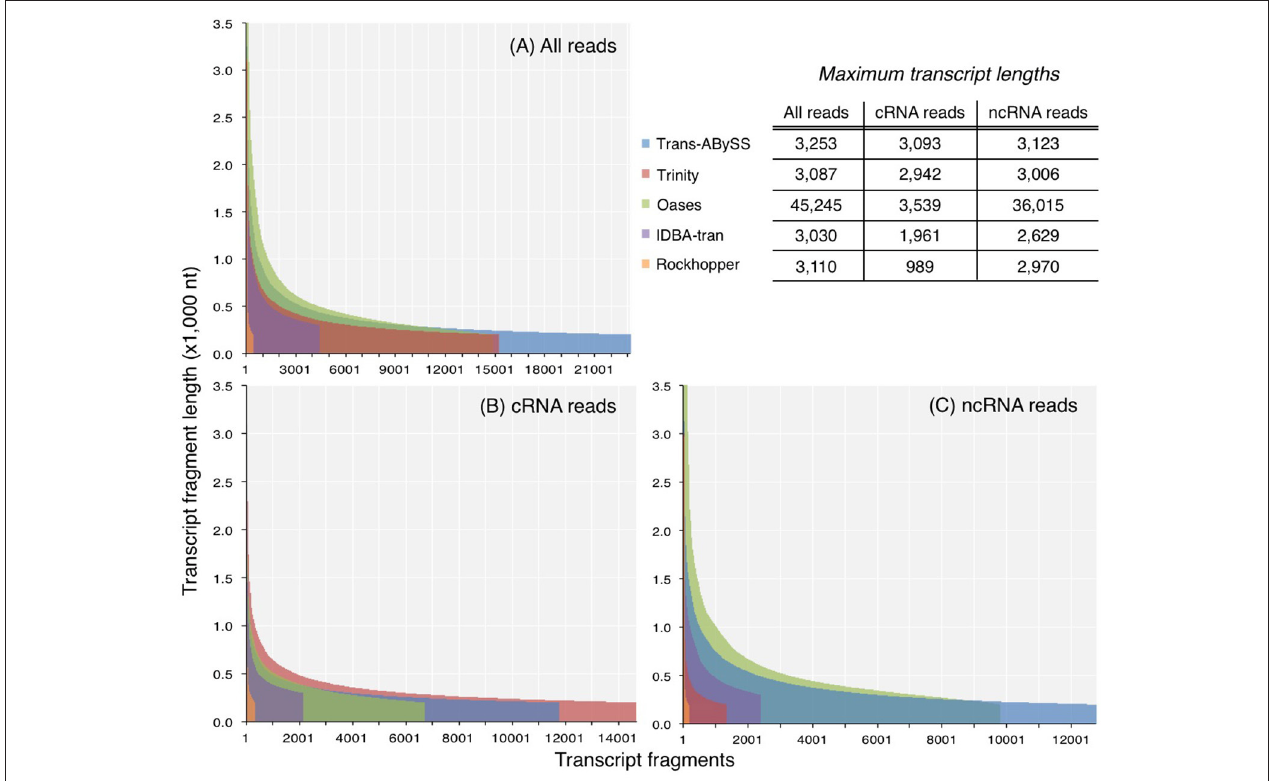
FIGURE 3 | Length distribution of transcripts in assemblies generated from (A) all reads, (B) coding RNA reads, and (C) non-coding RNA reads. Y-axis was truncated in (A) and (C) to visualize the shorter transcripts, which dominated the